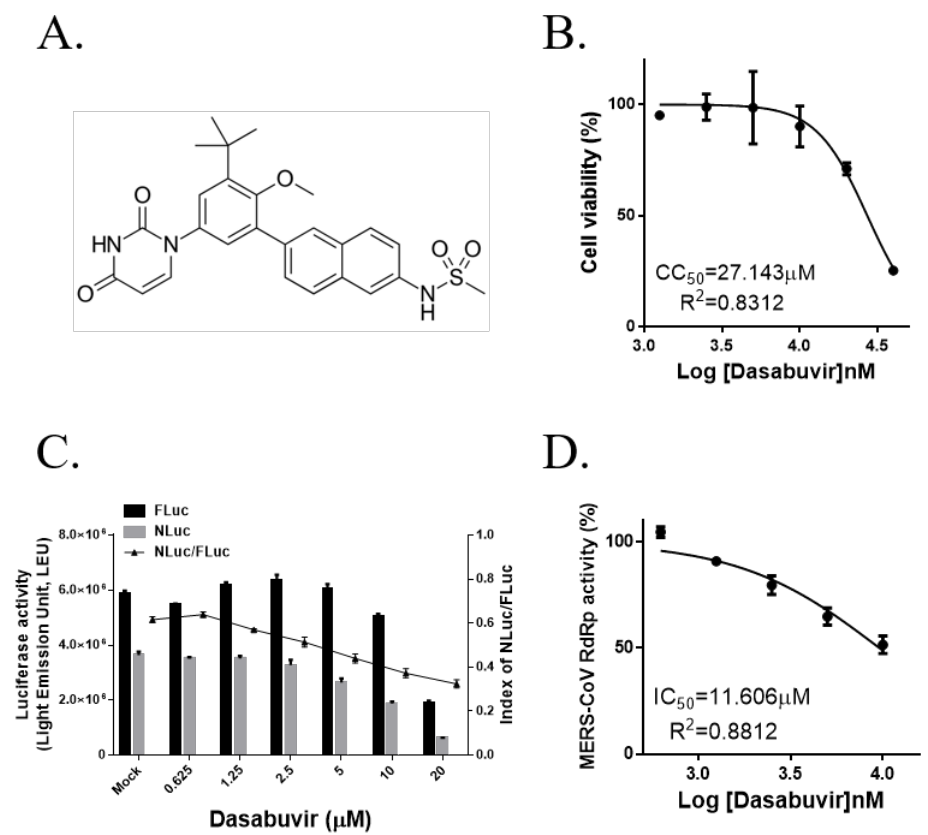
Figure 4. Effects of the non-nucleoside analog dasabuvir on Middle East respiratory syndrome coronavirus RNA-dependent RNA polymerase (RdRp) activity in the cell-based reporter assay system. ( A ) Chemical structure of dasabuvir. ( B ) The half-maximal cytotoxic concentration of dasabuvir was detected using 3-(4,5-dimethylthiazol-2-yl)-5-(3-carboxymethoxyphenyl)-2-(4-sulfophenyl)-2H-tetrazolium (MTS) assay after treatment in HEK293T cells for 18 h. ( C ) HEK293T cells were transiently transfected with p (+)FLuc- (−)UTR -NLuc and pN-termFlag-nsp12, and, after 6 h, cells were treated with the indicated concentrations of dasabuvir for 18 h. FLuc and NLuc activities were measured and the NLuc/FLuc ratio were determined. ( D ) The IC 50 value of dasabuvir was calculated via non-linear regression analysis. The data, which are representative of at least three independent experiments, are presented as the mean ± SEM. 3.5. Remdesivir (GS-5734) Inhibits MERS-CoV RdRp Activity in a Cell-Based Reporter Assay Remdesivir is a monophosphoramidate prodrug of an adenosine analog (Figure 5A). In prior research, remdesivir inhibited MERS-CoV infection in vitro with an IC 50 of 0.074 ± 0.023 μM in human airway epithelial (HAE) cells, and remdesivir targets RdRp and exoribonuclease (nsp14, ExoN) in MHV, suggesting resistance mutation [5]. Therefore, we evaluated the direct inhibitory effects of remdesivir on MERS-CoV RdRp activity. The drug was demonstrated to reduce the relative NLuc activity in a dose-dependent manner while maintaining consistent FLuc activity, and no cytotoxicity was observed at concentrations of up to 12μM (Figure 5B and 5C). The IC 50 of remdesivir was 5.028 ± 0.035 μM according to non-linear regression analysis (Figure 5D). There is the discrepancy between remdesivir IC 50 of 0.074 ± 0.023 μM in MERS-CoV infected HAE cells and IC 50 of 5.028 ± 0.035 μM in this system, which may be due to the different experimental conditions, using the artificially over- expressed MERS-CoV RdRp compared with using the infectious virus.